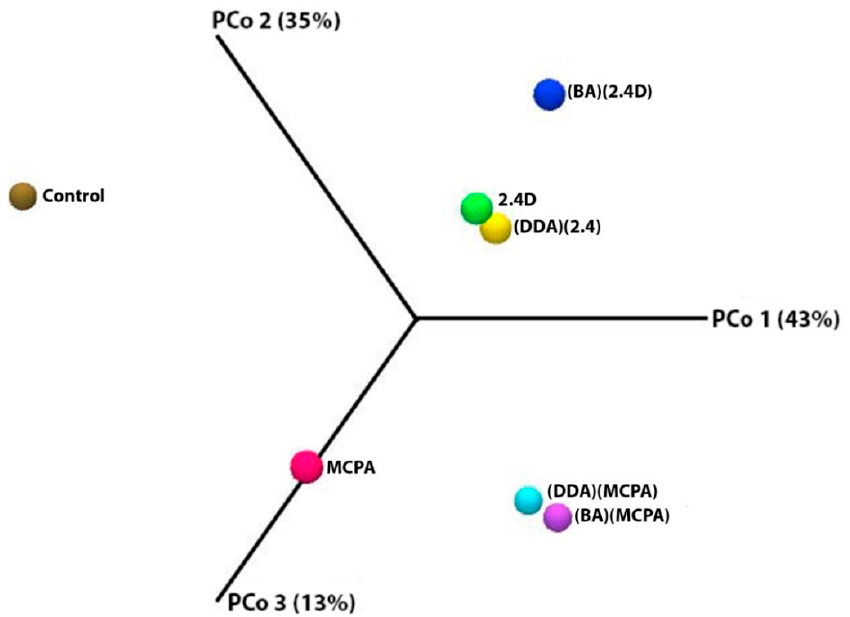
Figure 3. Coordinates analysis (PCoA) based on Bray-Curtis index for biogas-producing microbial community in the presence of HILs.